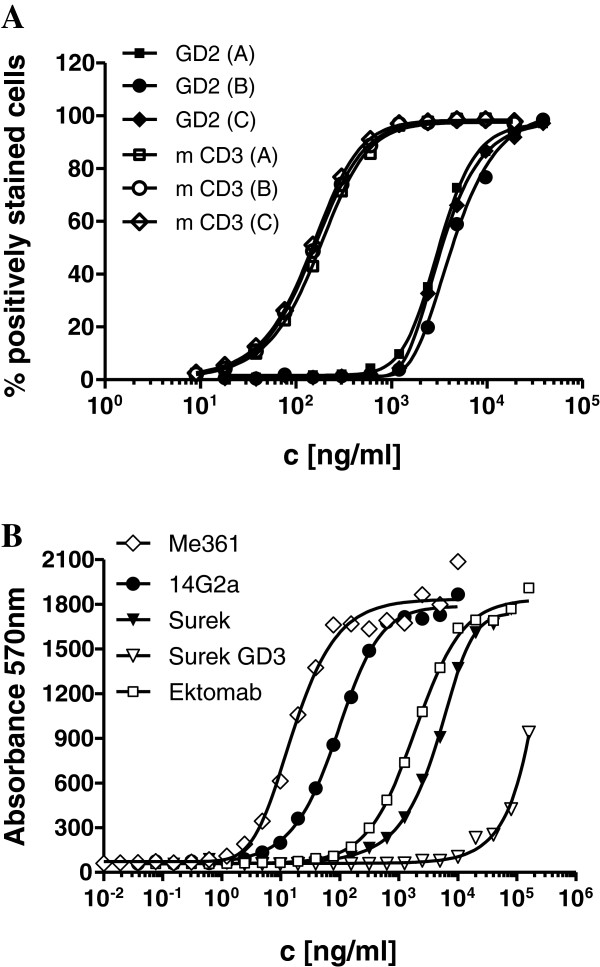
Binding of Surek and control antibodies. (A) Three different production batches A, B and C of Surek were compared for bispecific binding to either GD2 positive B78-D14 or to mouse CD3 expressing LBRM-33 cell lines by flow cytometry. In mean, binding to mouse CD3 (EC50 = 0.16 μg/ml [1.07 nM]) was 23 times stronger than binding to GD2 (EC50 = 3.6 μg/ml [24 nM]). (B) Binding curves of the monoclonal antibodies Me361, 14G2a, Surek and Ektomab to GD2 as measured by ELISA are displayed. Additionally, cross-reaction of Surek with GD3 is included. The figure shows one representative of three independent experiments. Mean calculated EC50 values were 0.018 μg/ml [0.12 nM] (Me361), 0.073 μg/ml [0.49 nM] (14G2a), 4.8 μg/ml [32 nM] (Surek) and 3.1 μg/ml [20.7 nM] (Ektomab).